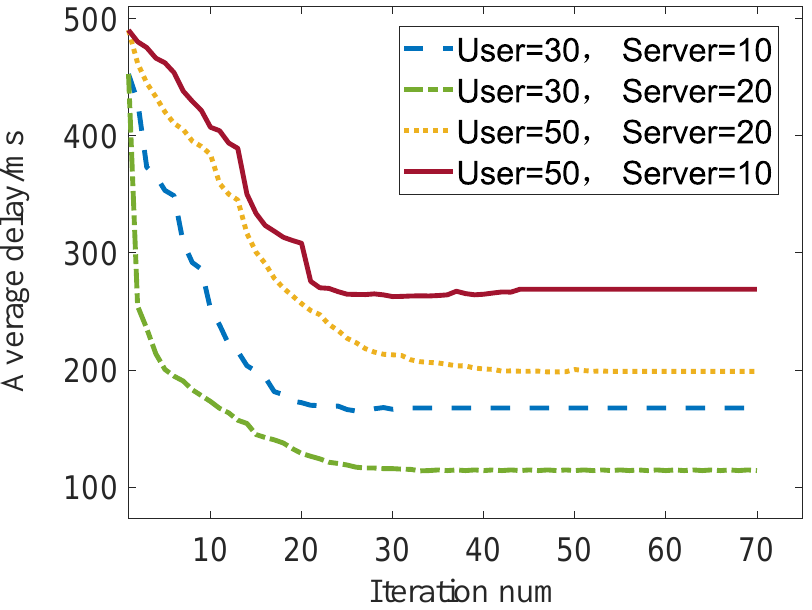
Figure 3. The convergence of the distributed DETO